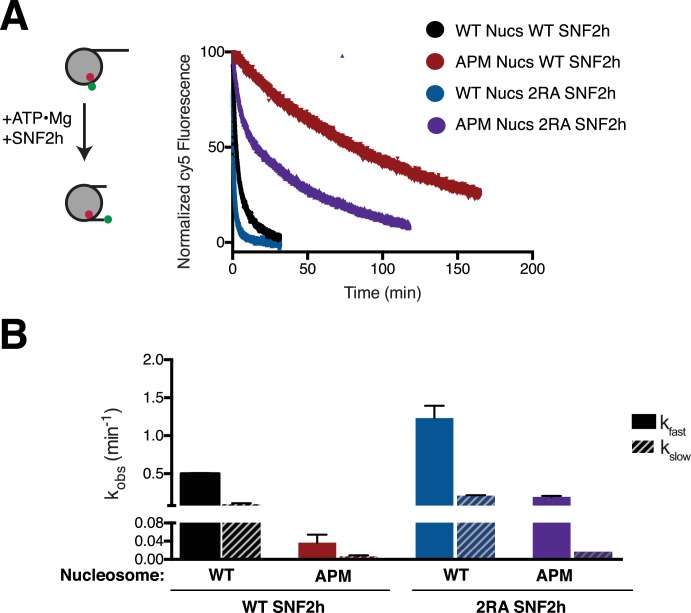
Ensemble FRET remodeling shows similar effects as the gel-based assay.(A) FRET remodeling assay. Saturating concentrations of enzyme were added to 8 nM FRET-labeled nucleosomes. Cy5 fluorescence was monitored over time and fit to a two-phase exponential decay. Reactions were normalized to the initial (maximal) and plateau (minimal) fluorescence from the fit. (B) Remodeling rates of the two phases. Error bars represent standard error of the mean for N = 3 replicates.10.7554/eLife.35322.014Figure 2—figure supplement 2—source data 1.Values used to obtain plots.